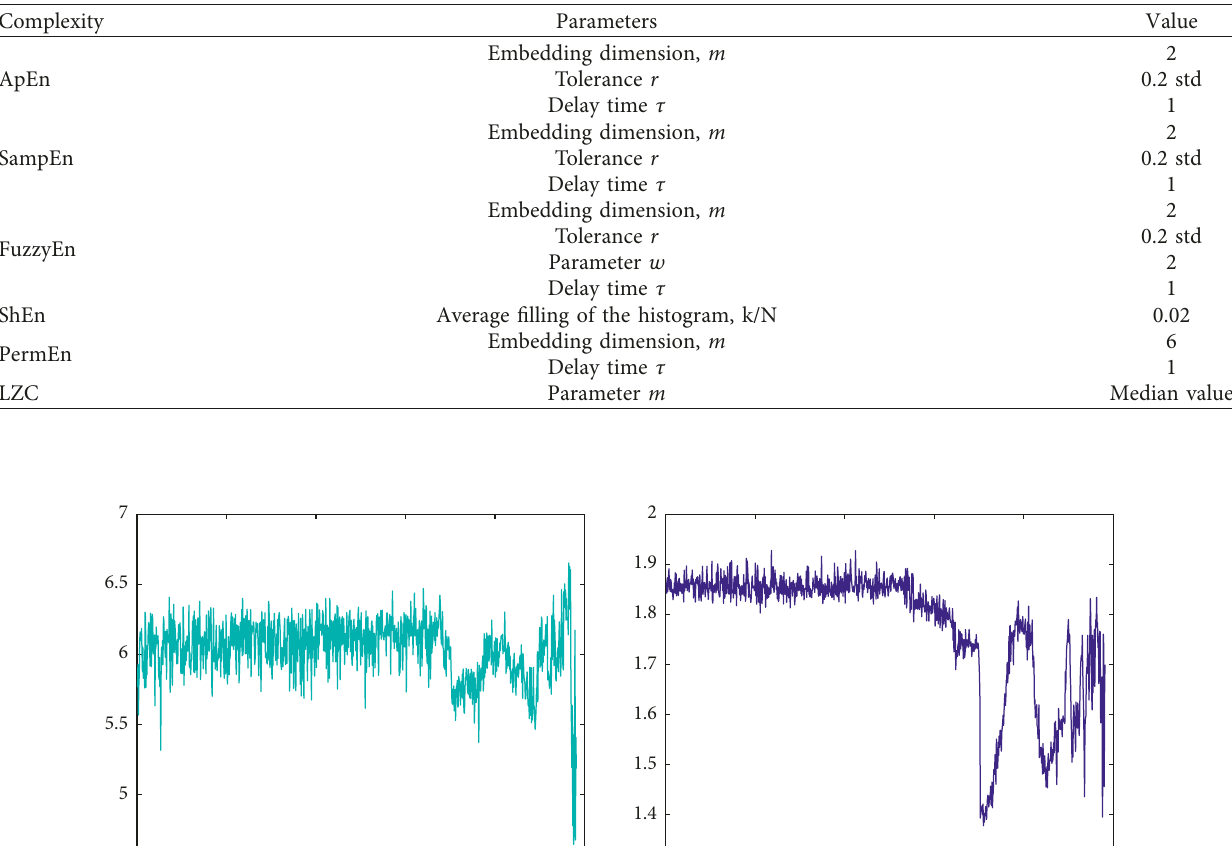
Table 4: The summary of the selected parameter